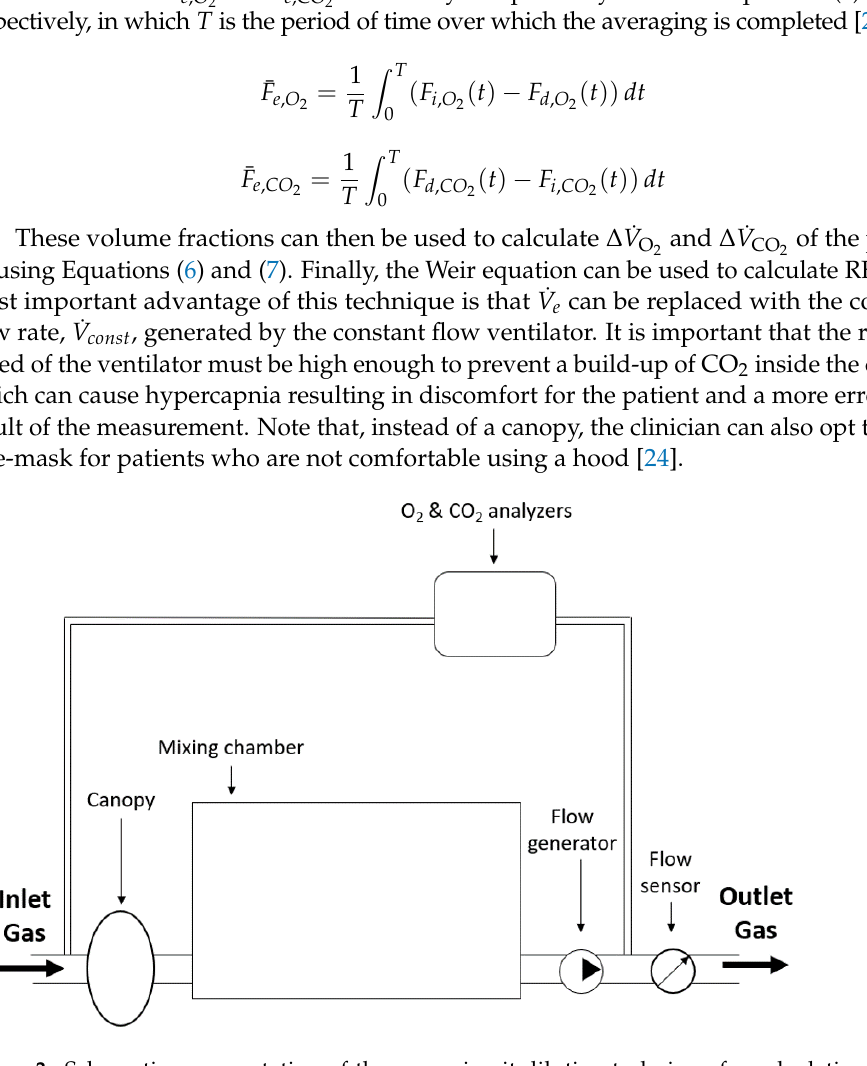
Figure 3. Schematic representation of the open-circuit dilution technique for calculating REE in spontaneously breathing subjects with the bold arrows indicating the direction of gas